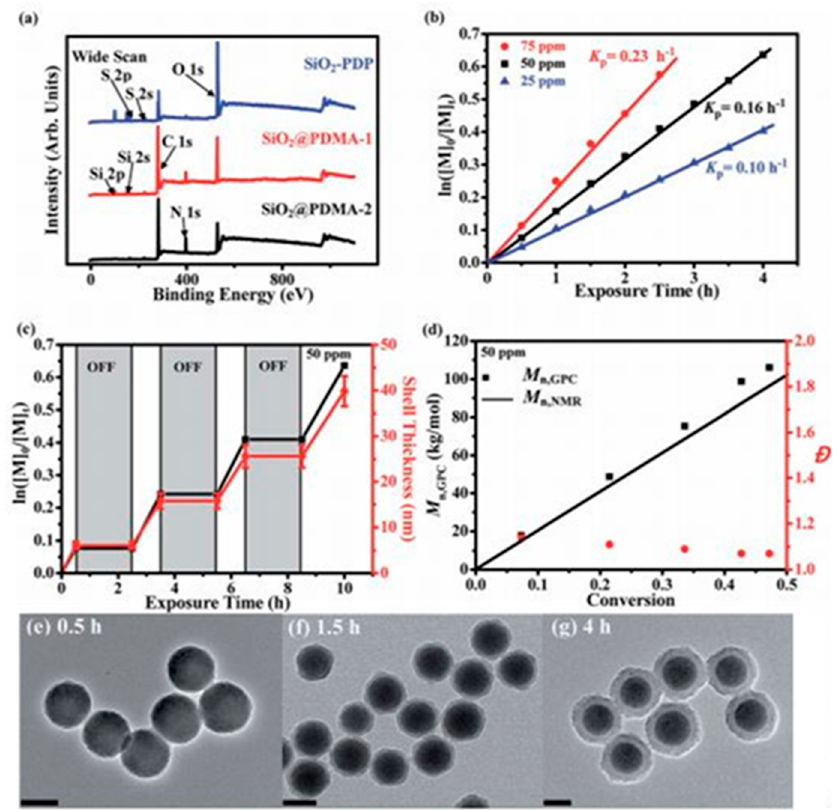
Figure 7. Surface-initiated PET-RAFT polymerization of DMA monomers from SiO 2 -PDP nanopar- ticles in acetonitrile with prior deoxygenation at 25 °C under blue LED light irradiation (4.8 W, λ max ¼ 465 nm, 1.0 mW cm 2 ). ( a ) XPS wide-scan spectra of SiO 2 -PDP, SiO 2 @PDMA-1, and SiO 2 @PDMA -2 nanoparticles; ( b ) plot of ln[M]0/[M]t versus exposure time t at three different Ru(bpy) 3 Cl 2 concentrations with reference to monomer concentration; ( c ) temporal control over polymerization upon on/off switching of light; and ( d ) evolution of Mn,NMR, Mn,GPC, and Ð versus monomer conversion. TEM images of ( e ) SiO 2 @PDMA-1, ( f ) SiO 2 @PDMA-2, and ( g ) SiO 2 @PDMA-3 nanoparticles. All scale bars are 100 nm [66].